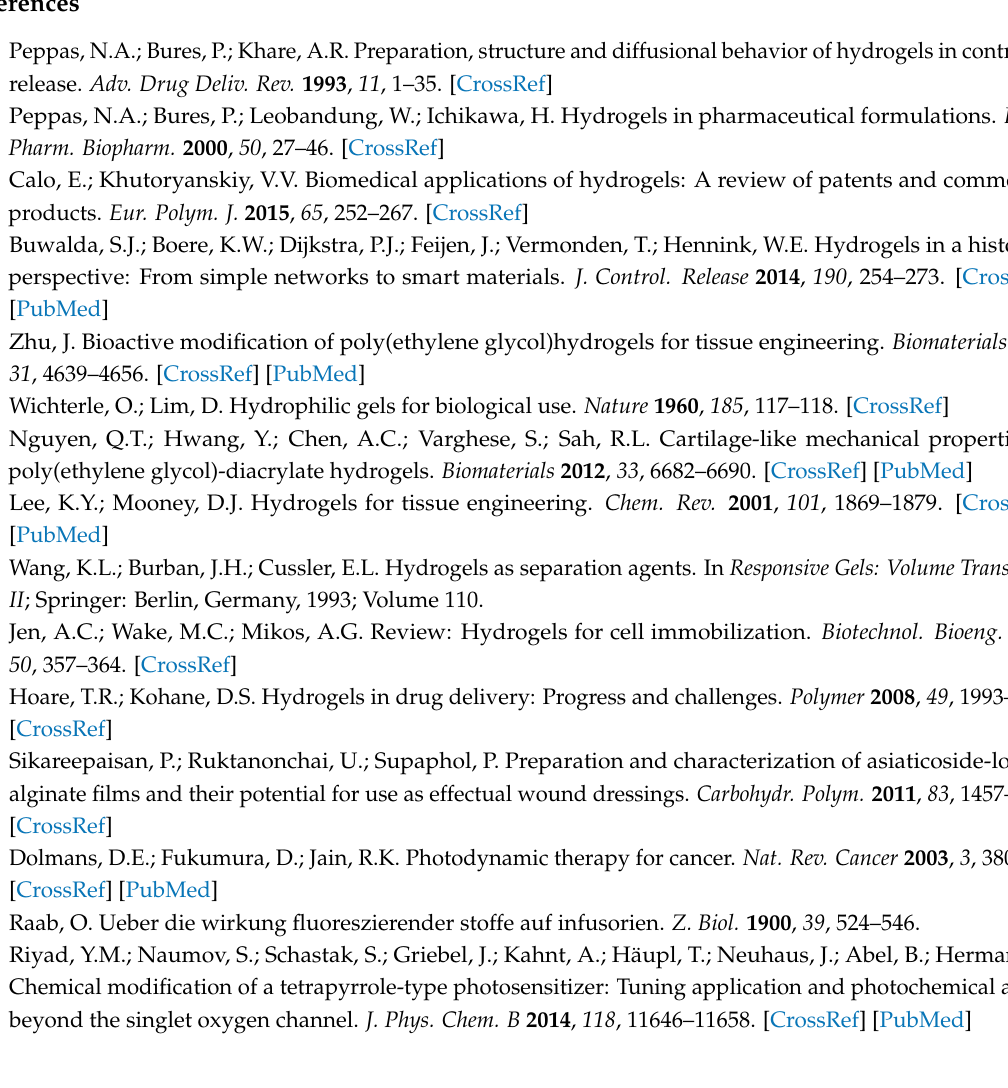
Figure S3: Photopolymerization kinetics of hydrogel formulations using three different α -HAP concentrations in dye-free formulations ( a ) and dye-added mixtures (i.e., with 0.01 wt % TMPyP) ( b ) with nitrogen inertization and at a light intensity of 12 mW cm − 2 , Figure S4: Molar percentages of α -HAP released into the PBS solution for the three photoinitiator formulations, Figure S5: Mass spectrum of 2-Hydroxy-1-[4-(2-hydroxyethoxy) phenyl]-2-methyl-1-propanone and possible cleavage products, Figure S6: Mass spectrum of the main cleavage product of (4-(2-Hydroxy)-ethoxybenzaldehyde), Figure S7: Mass spectrum of PEGDA 700 and its oligomers, Figure S8: Total ion chromatogram (orange) and selected ion chromatograms at different mass to charge ratios (black m / z = 121, red m / z = 99; blue m / z = 59, pink m / z = 55) of the washing solution after 24 h, Figure S9: Relative concentration of photoinitiator (red) and photo cleavage product (black) in the washing solutions, Table S1: Photopolymerization data including final conversions, induction times and maximum reaction rates for all samples measured by RT-FTIR spectroscopy (with and without TMPyP, with three different α -HAP concentrations and under air or inert